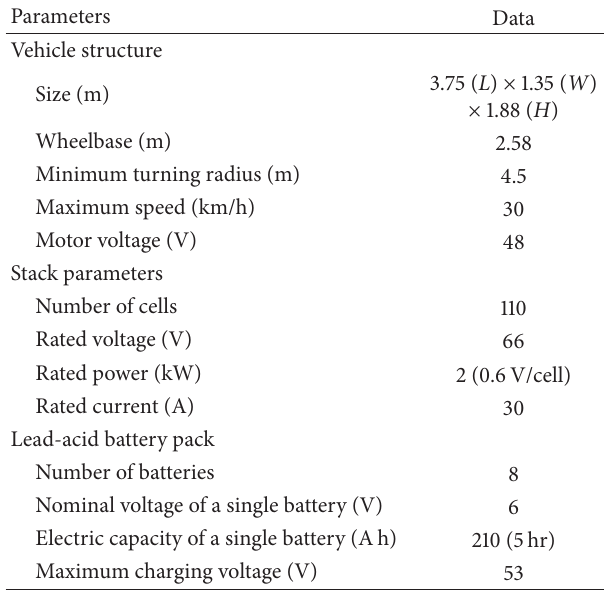
Table 1: Parameters of the vehicle structure and power